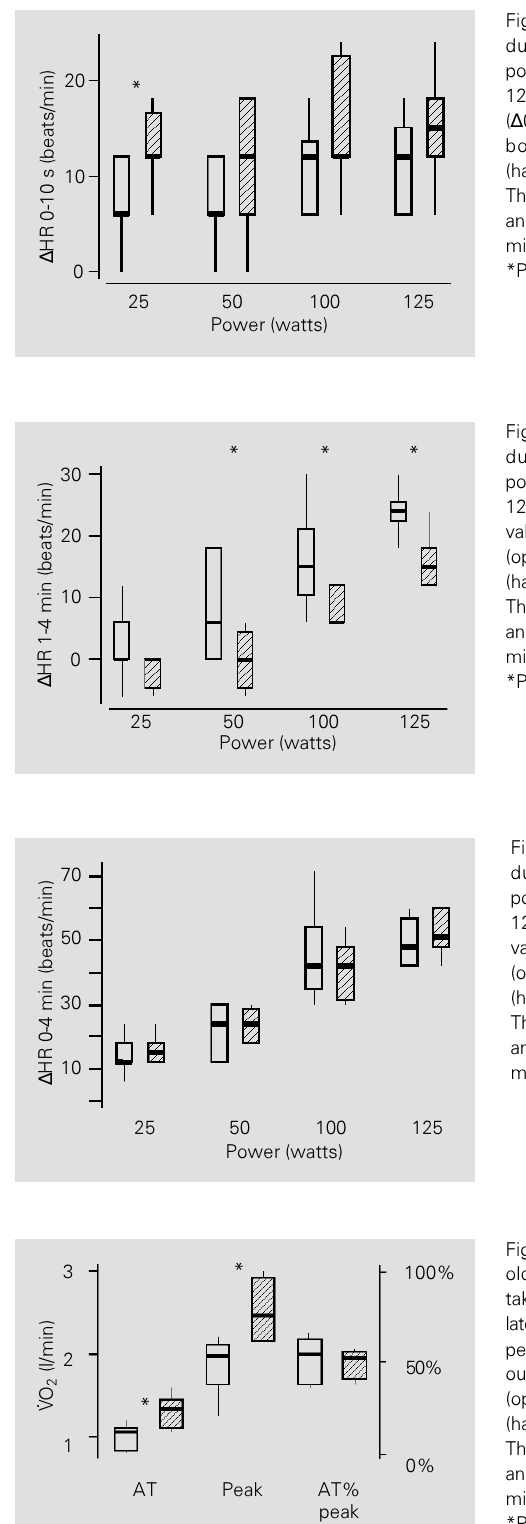
Figure 4 - The anaerobic thresh- . old (V O 2 AT), peak oxygen up- . take (V O 2 peak) and the AT re- . . lated to V O 2 peak (AT% V O 2 peak) values during a continu- ous protocol in the sedentary (open boxes, N = 7) and trained (hatched boxes, N = 8) groups. The data are reported as medi- ans, quartiles (1st and 3rd) and minimum and maximum values.